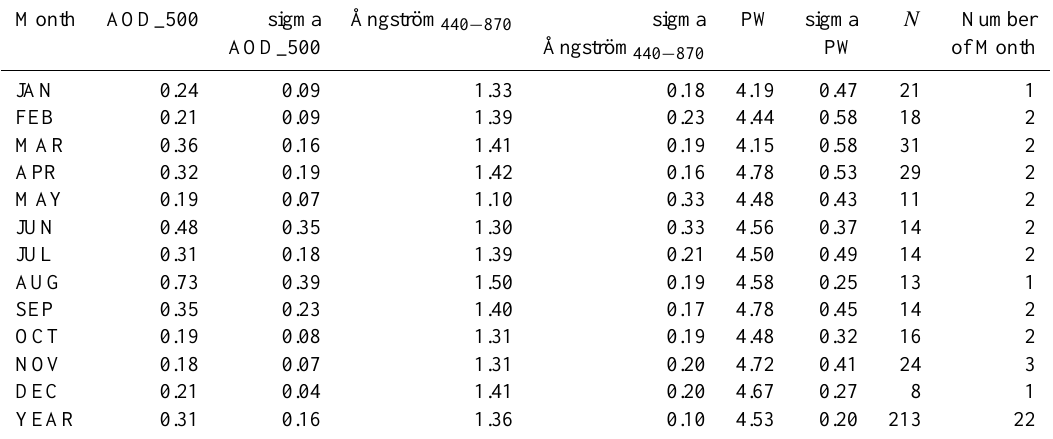
Table 1. Average values of model-related parameters from the database collected from November 2011 to November 2013 in USM Penang (latitude, 05 ◦ 21 (cid:48) N; longitude, 100 ◦ 18 (cid:48) E; elevation,